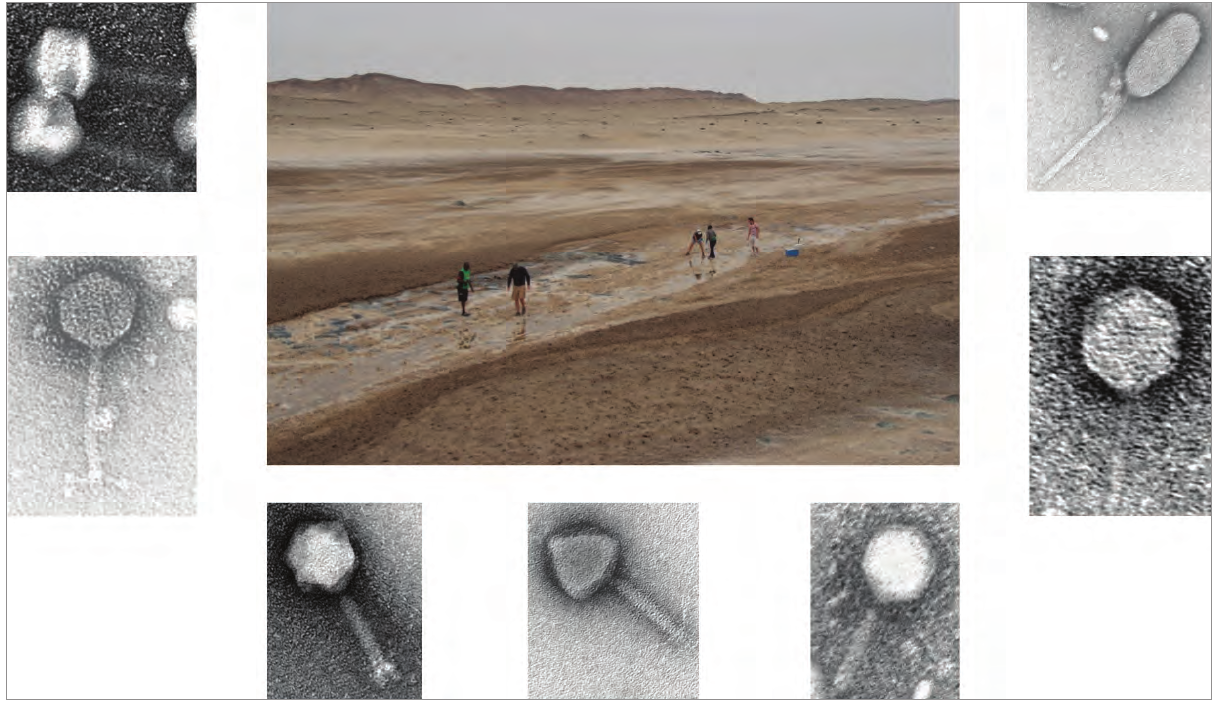
Photo: Don Cowan; micrographs: Lonnie van Zyl, University of the Western Cape (reproduced with permission). Figure 7: South Africa’s extensive desert areas, and their associated saline springs, harbour a wide variety of bacteriophages, about which almost nothing is known. Soil and saline water filtrates show large numbers of myoviruses and siphoviruses.